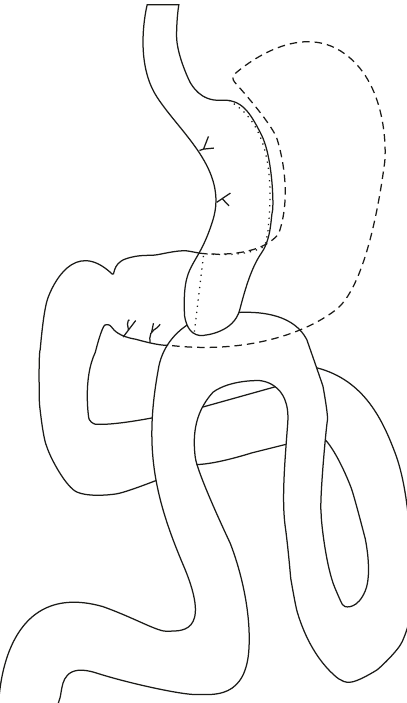
Figure 3: Drawing representing sleeve gastrectomy with omega loop anastomosis. The part in dotted line was